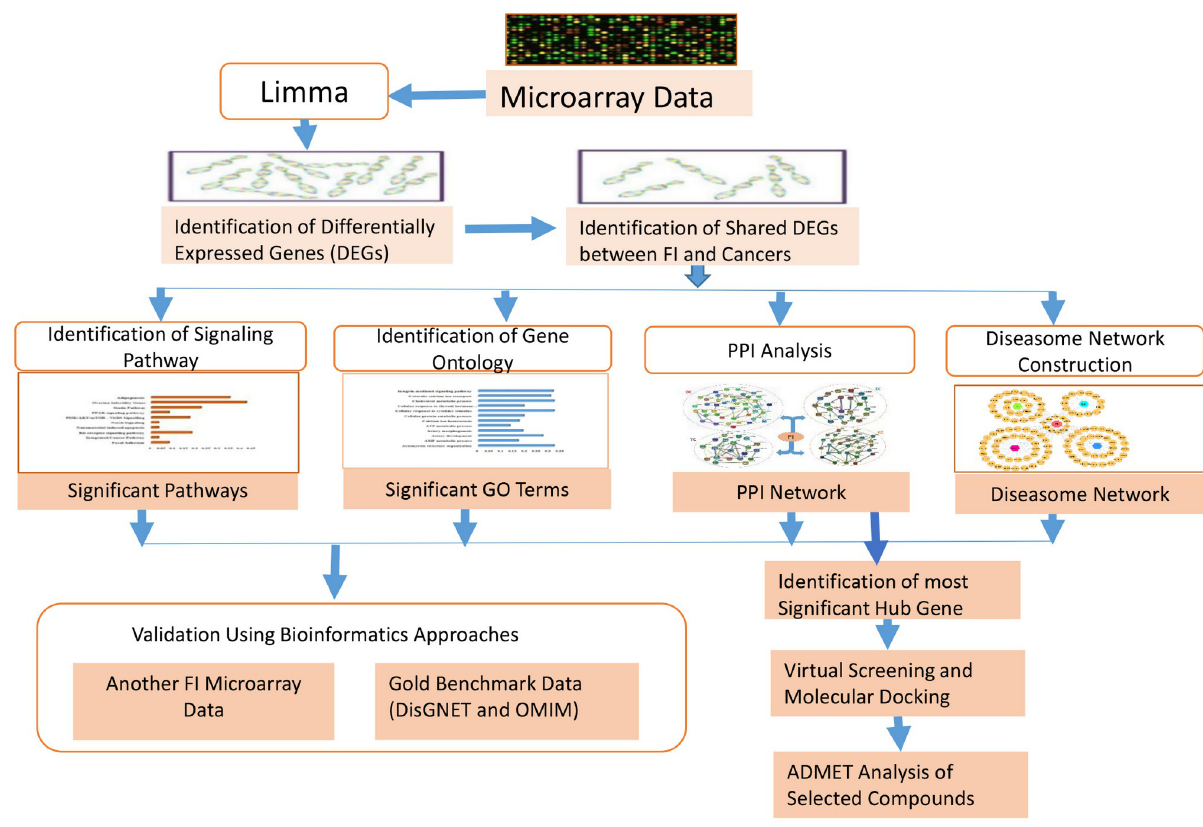
Fig 1. Block diagram of the proposed bioinformatics and system biology